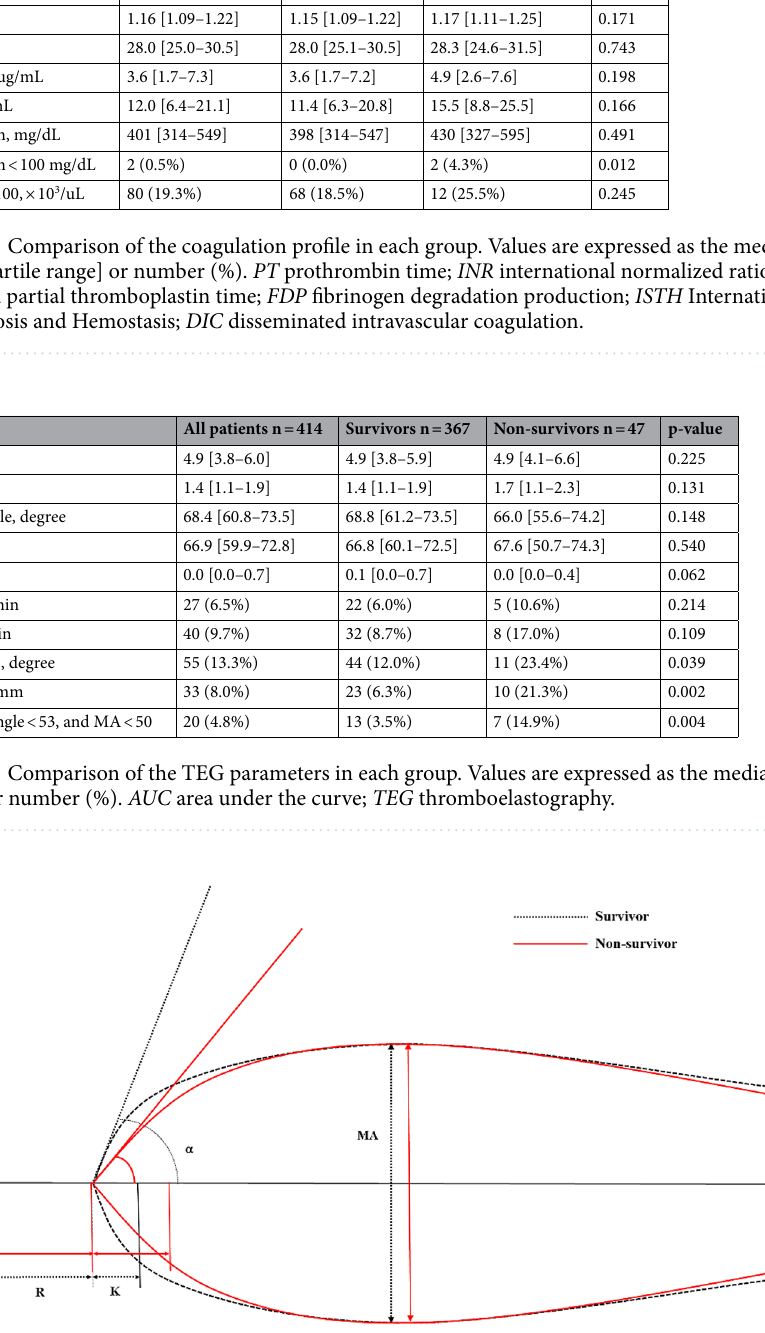
Figure 3. Graphical representation of thromboelastographic tracings and parameters pertaining to the subjects in the survivor (Black dotted line) and non-survivor (Red solid line) groups. R reaction time; K kinetic time; α alpha angle; MA maximal